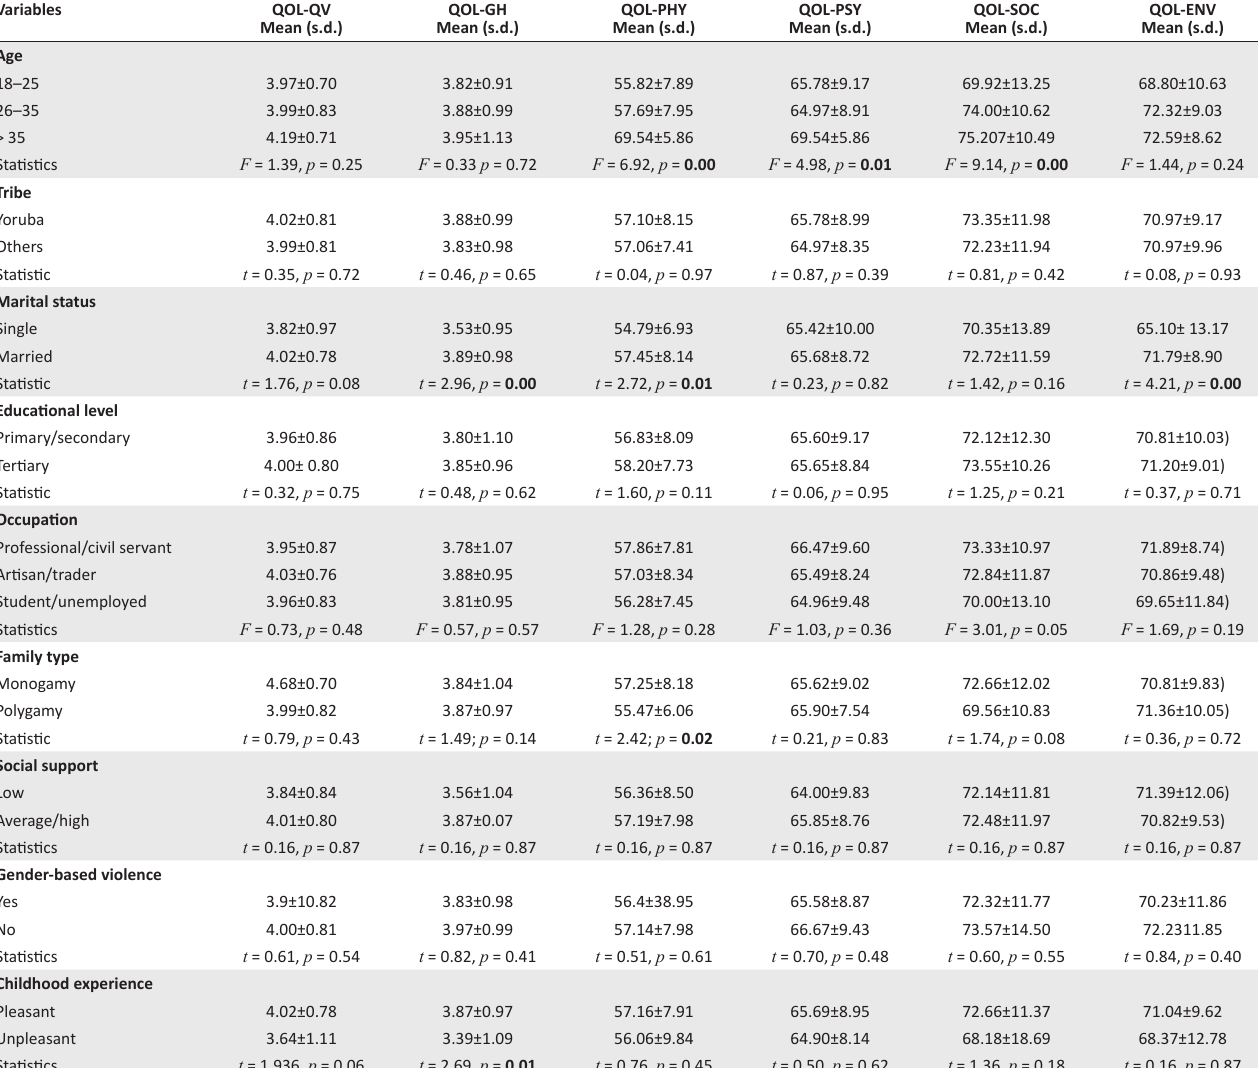
TABLE 7: Relationship between quality of life sociodemographic characteristics (both